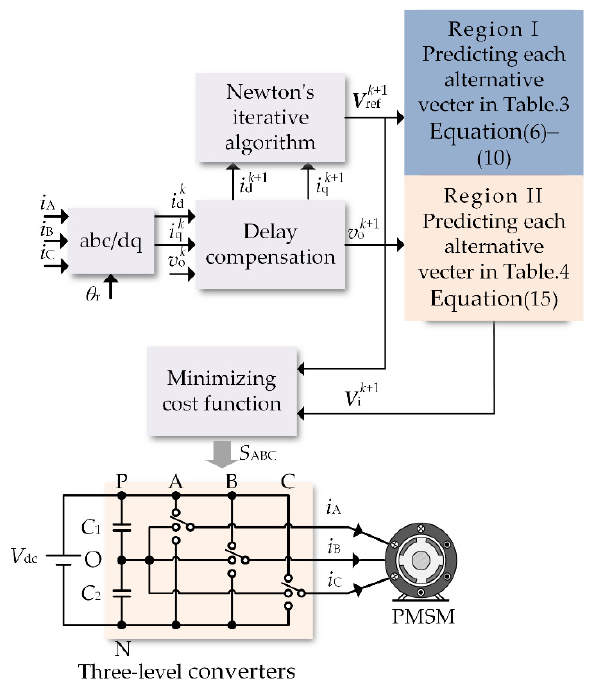
Figure 6. The block diagram of the proposed MPCC.